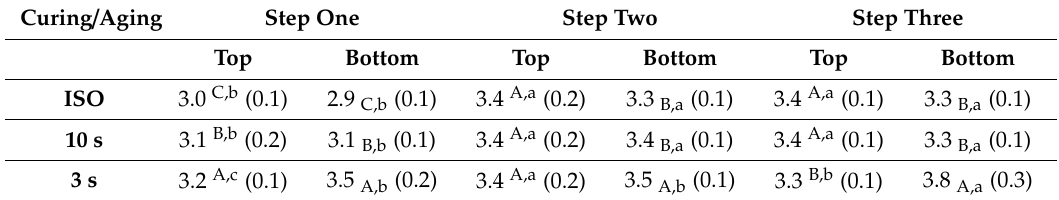
Table 6. Depth-sensing indentation test: mean Creep Cr in % (mean and standard deviation). Superscript / subscript letters indicate homogeneous groups; Capital letters indicate sub-groups related to columns; Lowercase letters indicate sub-groups related to rows; Tukey’s post-hoc test ( α = 0.05). Curing /